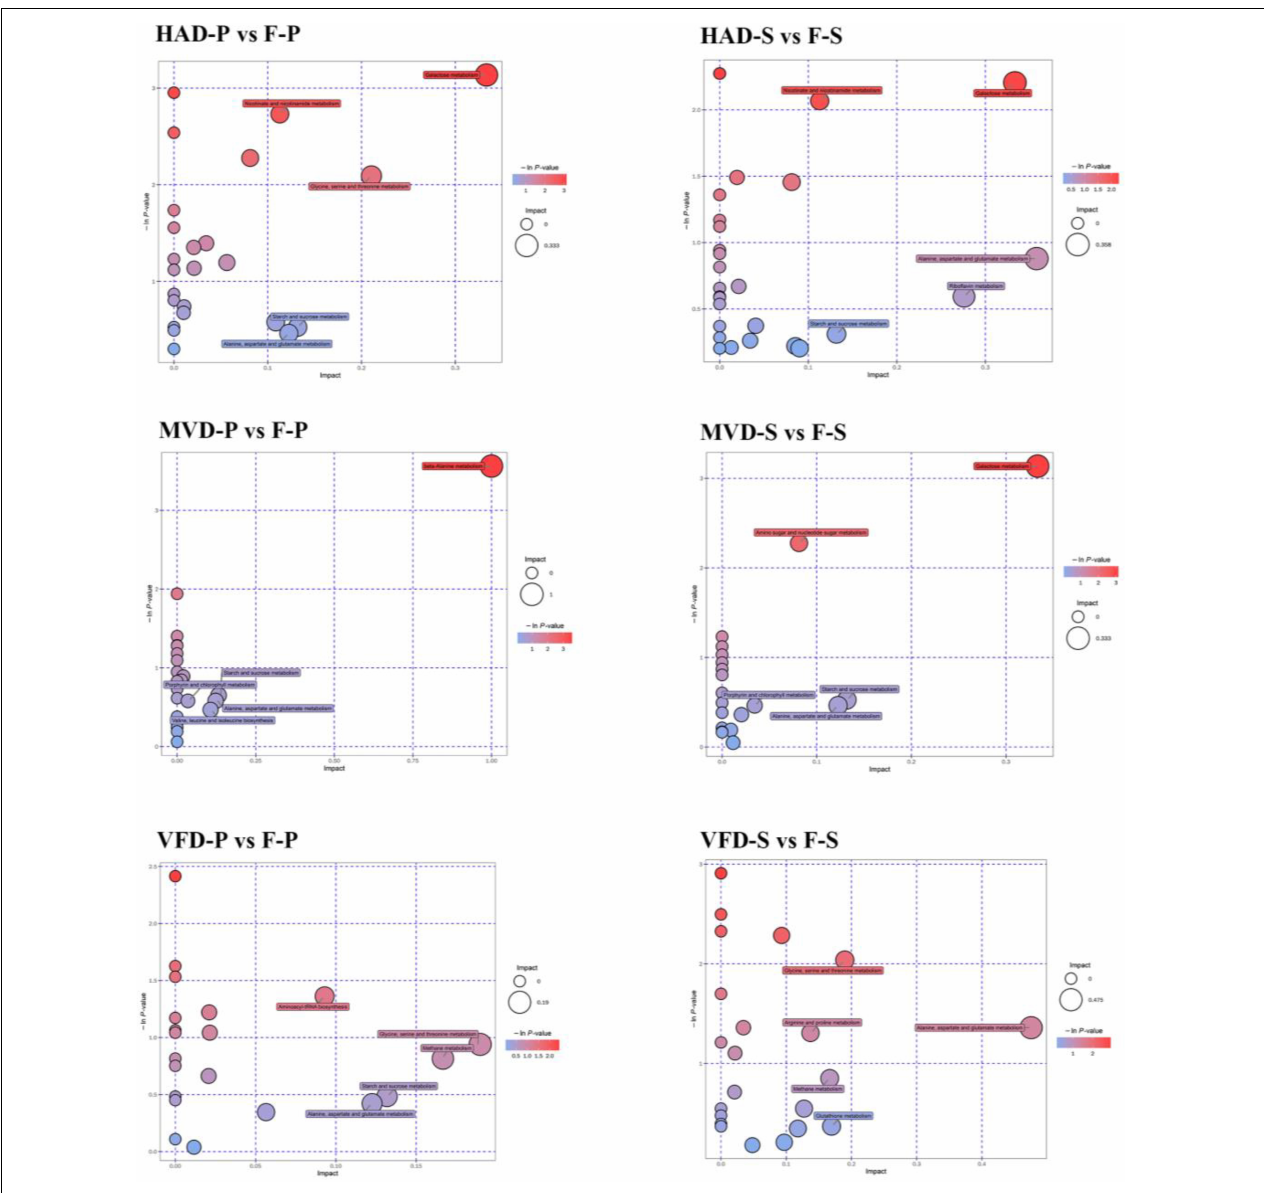
FIGURE 6 | Metabolic enrichment pathway